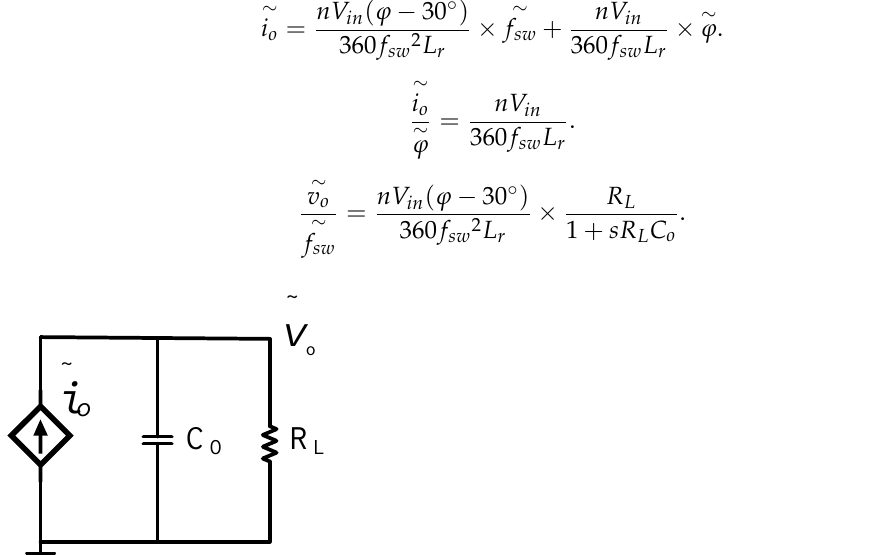
Figure 11. Simplified small-signal model of the proposed converter. ( C o : output capacitor; R L : output load resistant; i o : small-signal value of output current; v o : small-signal value of output voltage).